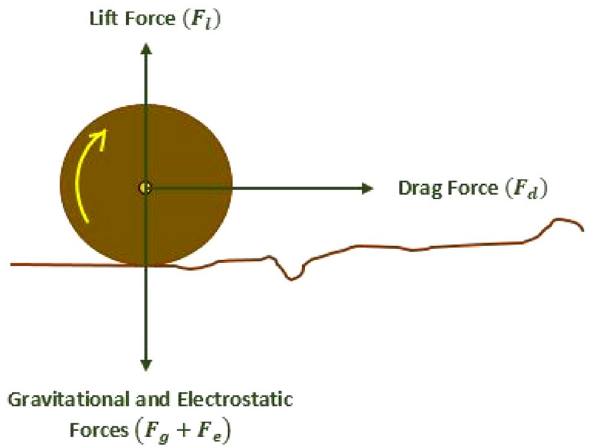
Fig. 1 Fine particle which is in the state of equilibrium over the rock